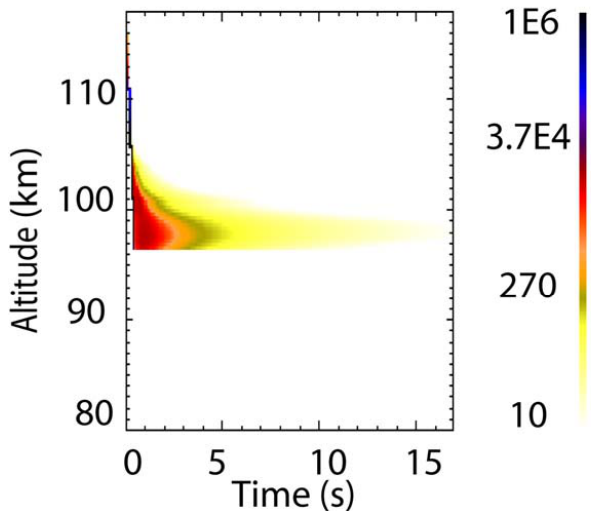
Fig. 4. 17s RTI simulation using Jicamarca conditions for 04:00a.m. LT, one 1 June. The meteoroid mass is 0.01mg, traveling at a velocity of 55km/s, composed of an atomic mass of Figure 4. 17 second RTI simulation using Jicamarca conditions for 4:00am LT, on June 1 st . The meteoroid mass is 0.01mg, traveling at a velocity of 55 km/s, composed of an atomic mass of 25 AMU.